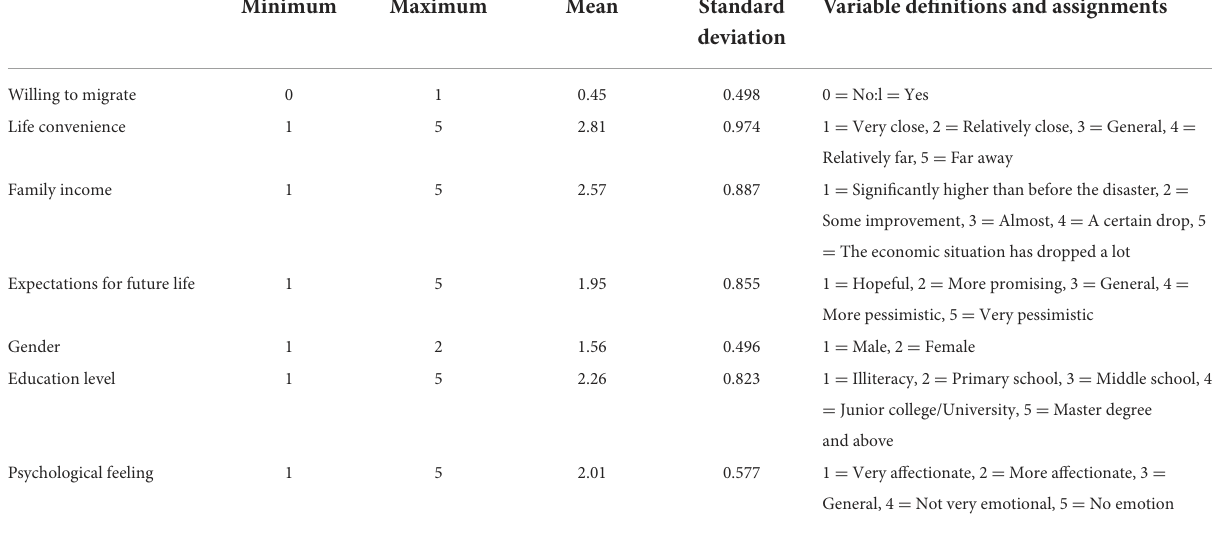
TABLE 2 Variable description.